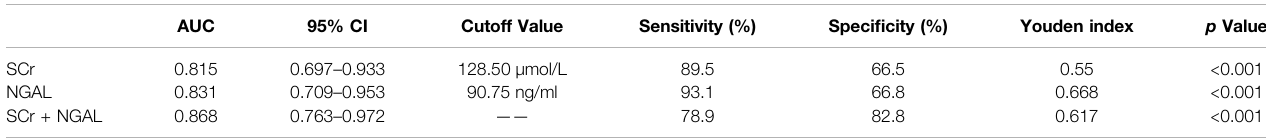
TABLE 3 | Cutoff value of different biomarkers in the prediction of response to volume expansion therapy in patients with cirrhosis and AKI. AUC 95% CI Cutoff